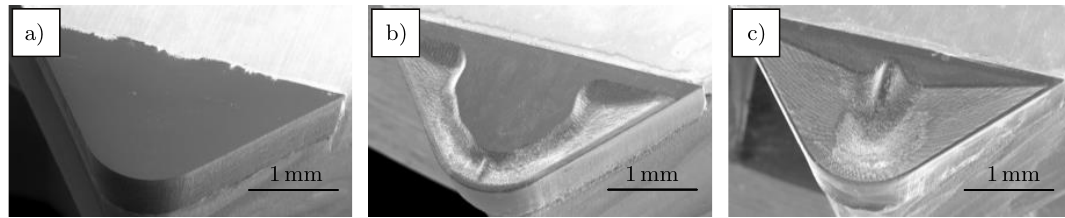
Figure 2. Rake face modifications to enhance machinability ( a ) Plane rake face ( b ), ( c ) different tool breaker geometries according to [21].